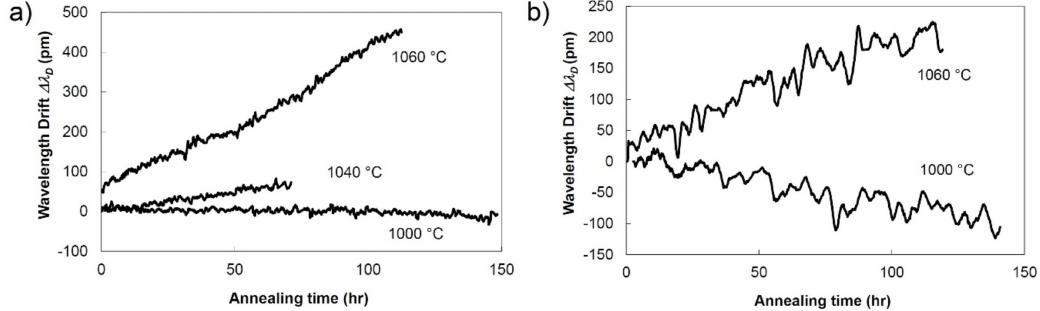
Figure 6. Bragg wavelength drift of a Type II FBG made using 1.6-ps pulses ( a ) in SMF-28 ( b ) in pure core silica fiber (reproduced from [52]).